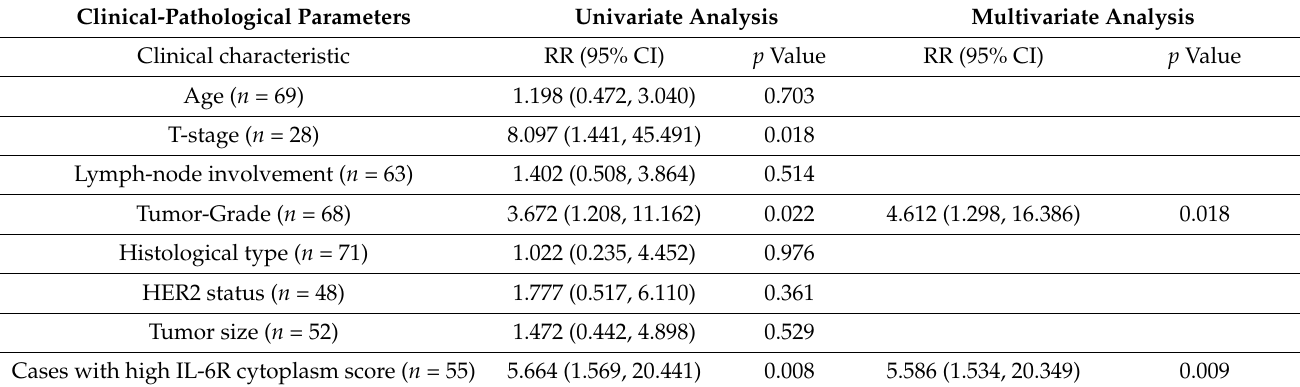
Table 4. Cox regression analyses of disease specific survival in ER+ breast cancer